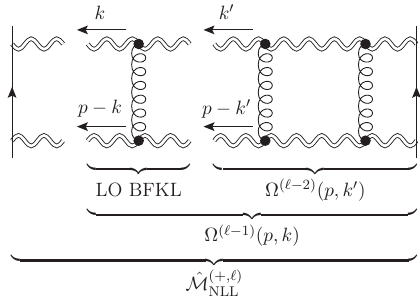
Figure 3 . Graphical representation of the amplitude at NLL accuracy, as obtained through BFKL Figure 2: Representation of the two Reggeon amplitude and the corresponding BFKL evolution. The addition of one rung corresponds to applying once the leading-order BFKL evolution wavefunction. A single application of the BFKL Hamiltonian adds a rung in the ladder. 2) . This gives the wavefunction at order ( ` 1) , according to on the wavefunction of order ( `   ( (cid:96) ) ( p ) , is obtained by integrating over the wavefunction eq. (2.17). Closing the ladder and integrating over the resulting loop momentum gives the reduced The amplitude at (cid:96) loops, M amplitude, according to eq. (2.11). Ω ( (cid:96) − 1 ) ( p , k ) , which itself consists of (cid:96) − 1 rungs. Figure taken from [ 15 ] under